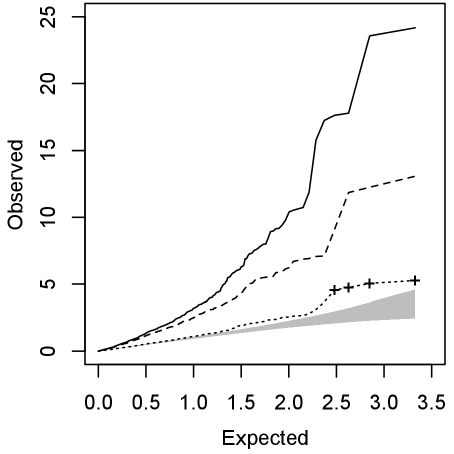
Figure 1. QQ-plot of -log 10 (p-value) from the test statistics using the three different estimates of the variance of the allele frequency in the sample pool: accounting for sample size in the pool (solid – variance # 1), accounting for samples size and read depth (dashed – variance # 2) and additionally account- ing for variation in amounts of DNA in pool construction (dotted – variance # 3). The 95% confidence interval for the expected distribution with no association and independent variants is shaded. The p-values for the four most significant variants are indicated with